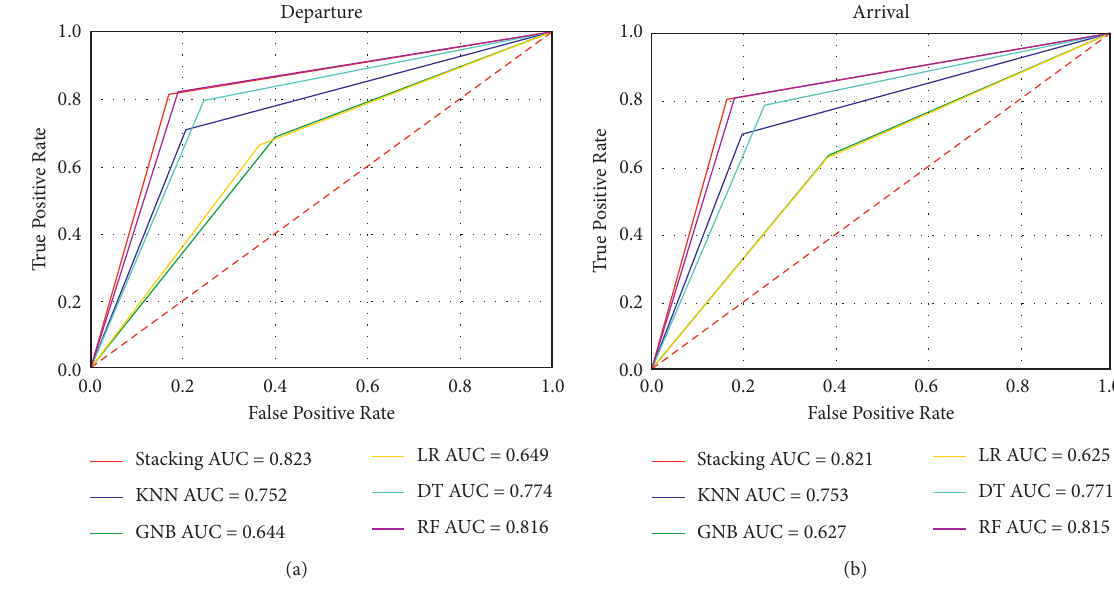
Figure 8: Receiver operating characteristic curve: (a) departure; (b) arrival. Table 4: The departure prediction results of different first-level learners.